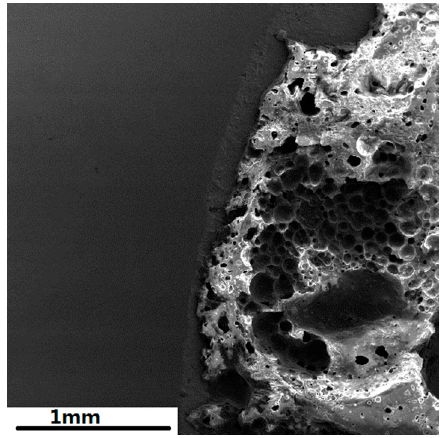
Figure 3. SEM micrograph of steel-slag interface in floater steel.